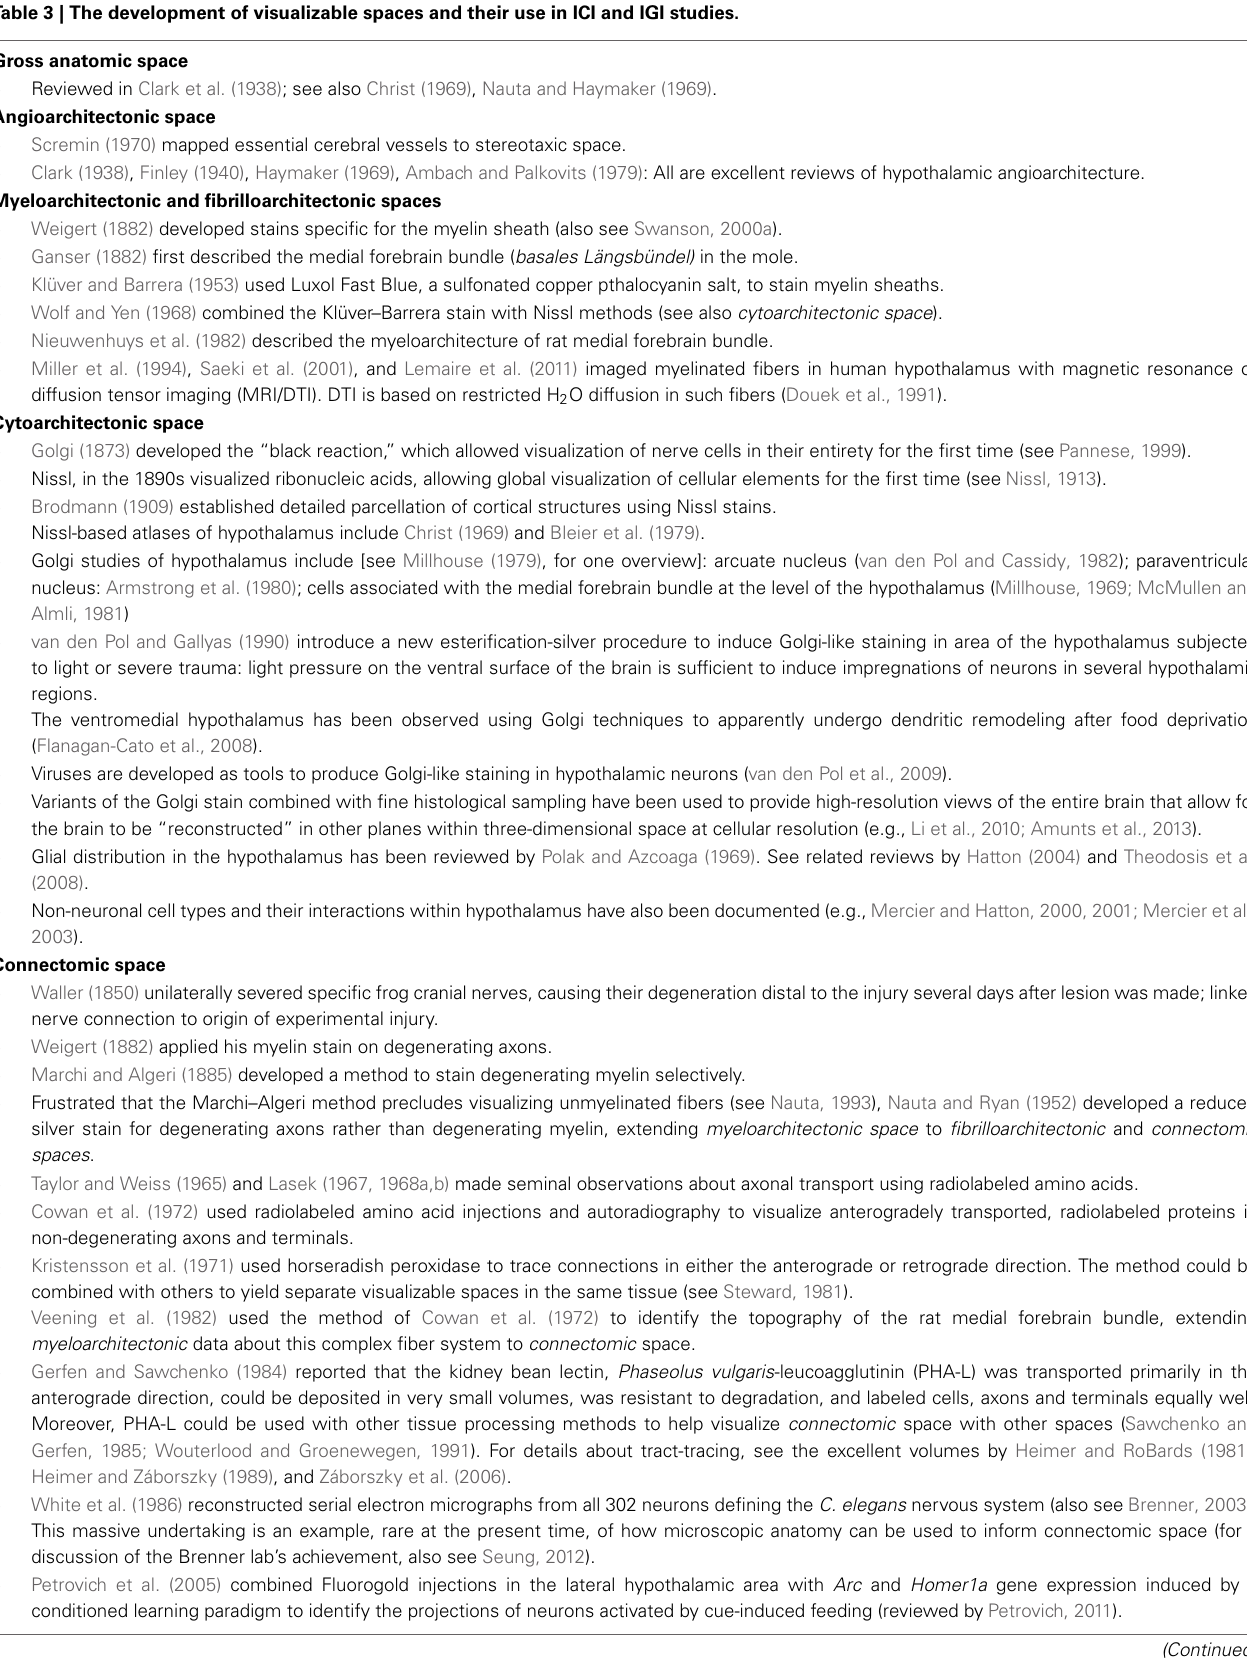
Table 3 | The development of visualizable spaces and their use in ICI and IGI